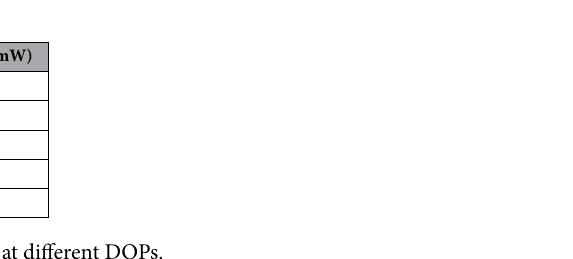
Table 1. Multiple stable state DSR operation at different